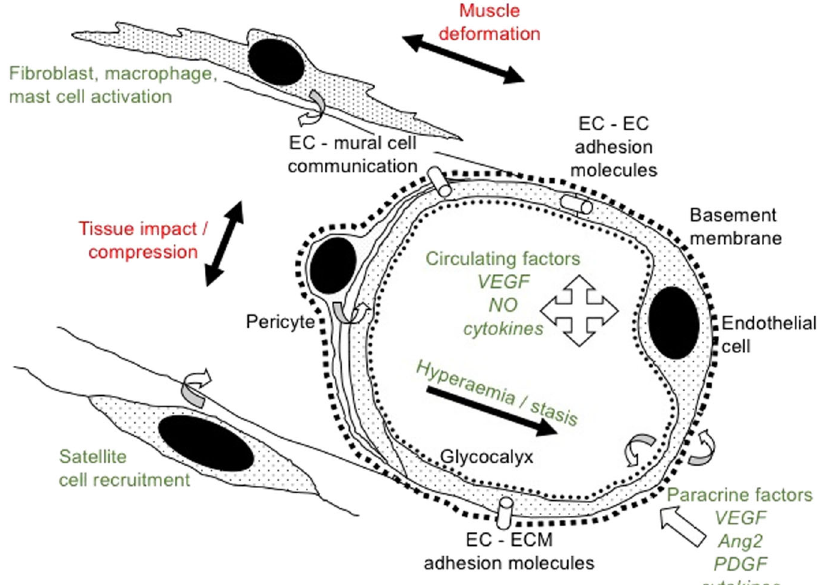
Fig. 4 Overview of mechanisms involved in regulating vascular function and angiogenesis. Expansion of the microcirculation may be elicited by a number of discrete or complex stimuli, involving independent or synergistic mechanisms. These include mechanical factors (either sensed directly by cells or indirectly via the extracellular matrix, ECM) involving initial tissue compression and haemostasis, and subsequent muscle deformation and hyperaemia (e.g., wall strain, shear stress). Activation of resident or in fi ltrating mural cells (e.g., macrophages, mast cells), either directly due to mechanical trauma or indirectly by the following cytokine storm, may in turn activate endothelial cells (EC). The ef fi cacy of other cell types important for muscle regeneration, such as satellite (mesenchymal stem) cells, appears to be related to their proximity to capillaries; perivascular pericyte communication with EC may modulate the response. Finally, chemical signals from remote or local paracrine sources (e.g., cellular release or cleavage from ECM-binding sites) complete the repertoire required to free EC from their usual quiescence. Figure is adapted from Egginton 106